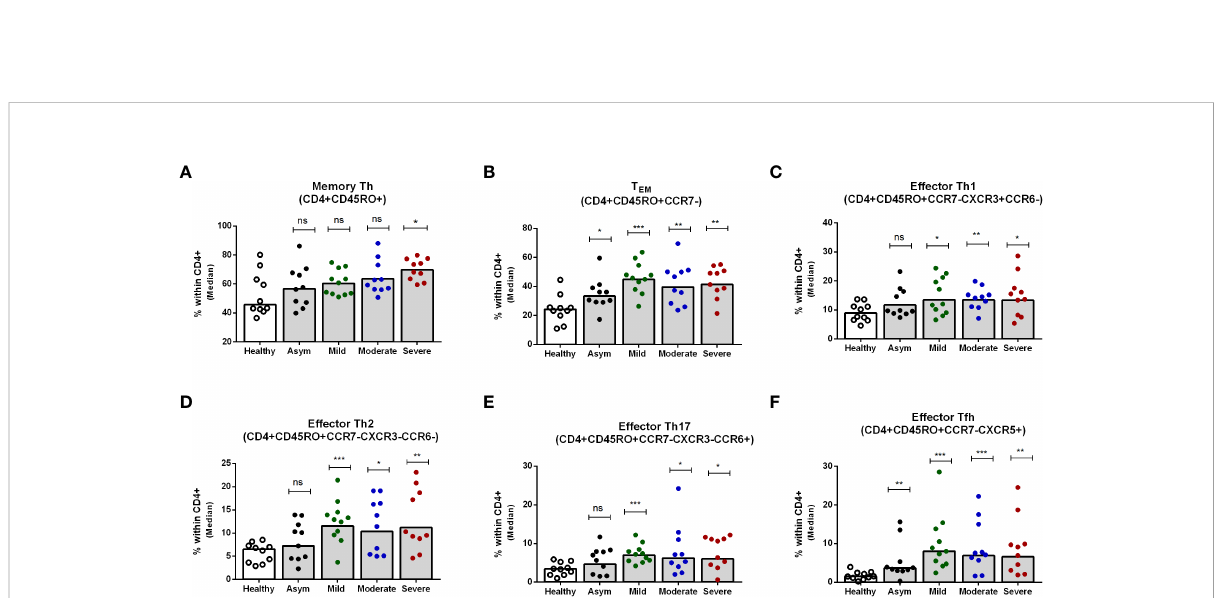
FIGURE 4 Frequencies of peripheral blood CD4+ memory Th cells, effector memory Th cells, and effector Th1, Th2, Th17 and Tfh cells in patients with differing disease severity of COVID-19, compared to healthy controls. Frequencies of (A) memory Th (CD4+CD45RO+), (B) effector memory TEM (CD4+CD45RO+CCR7-), (C) effector memory Th1 (CD4+CD45RO+CCR7-CXCR3+CCR6-), (D) effector memory Th2 (CD4+CD45RO+CCR7- CXCR3-CCR6-), (E) effector memory Th17 (CD4+CD45RO+CCR7-CXCR3-CCR6+), and (F) effector memory Tfh (CD4+CD45RO+CCR7-CXCR5+) populations within CD4+ cells in PBMCs isolated from healthy adults (n = 10) and patients with asymptomatic, mild, moderate and severe COVID-19 on day 7 (n = 10-11 per group). Each symbol represents the percentage of cells for one individual, and bars indicate median values. Statistical analysis was performed between healthy controls and patients using Mann-Whitney U test. *P < 0.05, **P < 0.01, ***P <